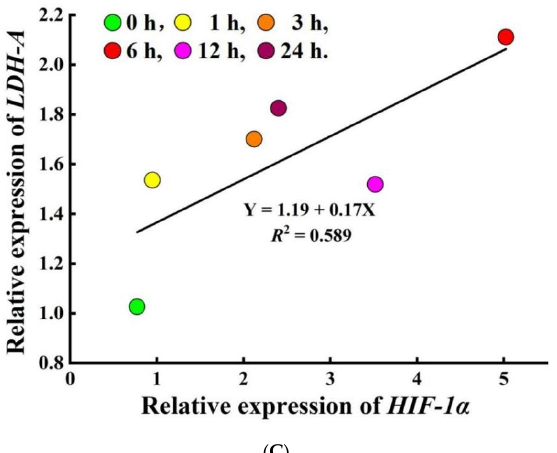
Figure 8. HIF-1 α and LDH-A gene expression ( A , B ) and their correlation ( C ) under hypoxic stress. Different letters indicate significant differences ( p < 0.05).